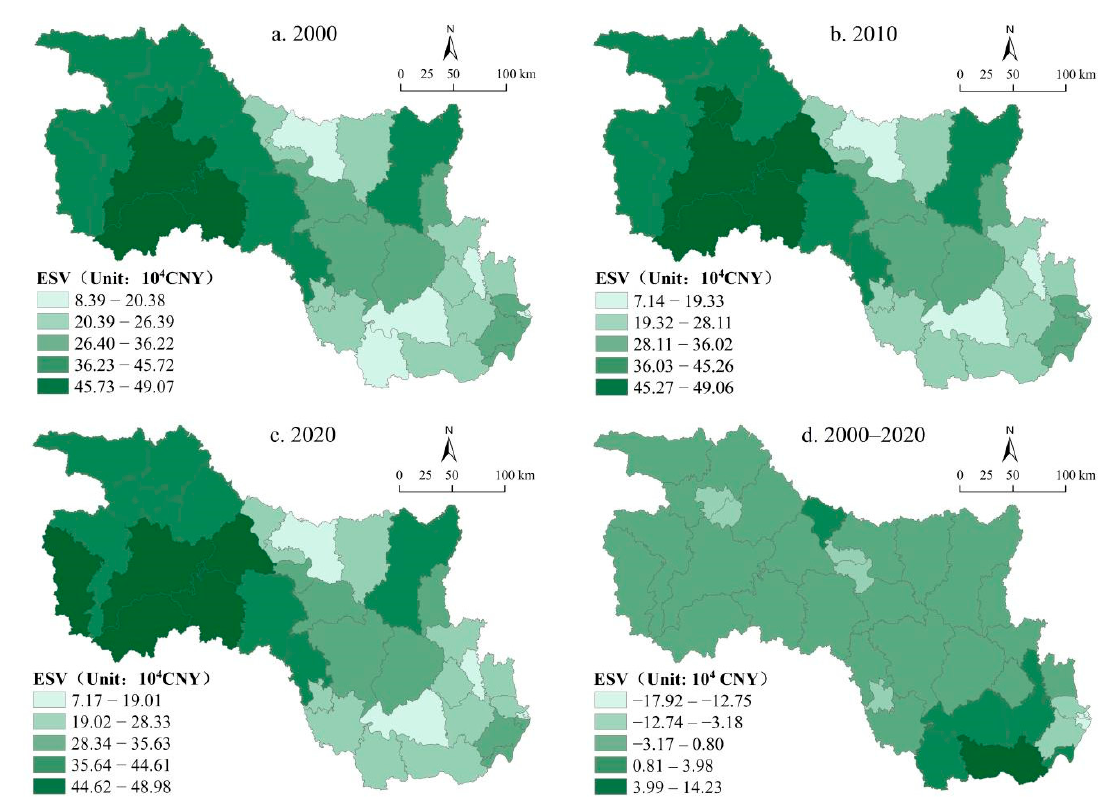
Figure 5. Spatial distribution of ESV ( a – c ) and the change rates ( d ) in the HRB of Hubei Province for 2000, 2010, and 2020.